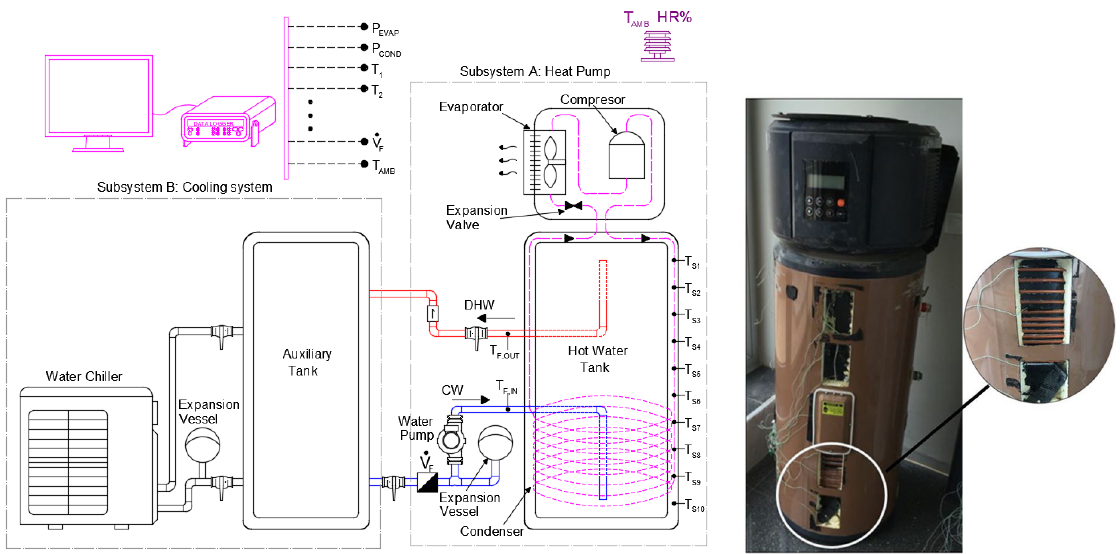
Figure 1. Experimental